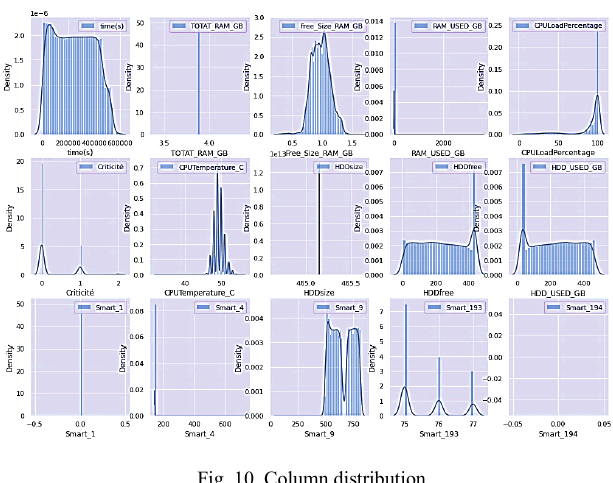
Fig. 6. Import of the CSV file.